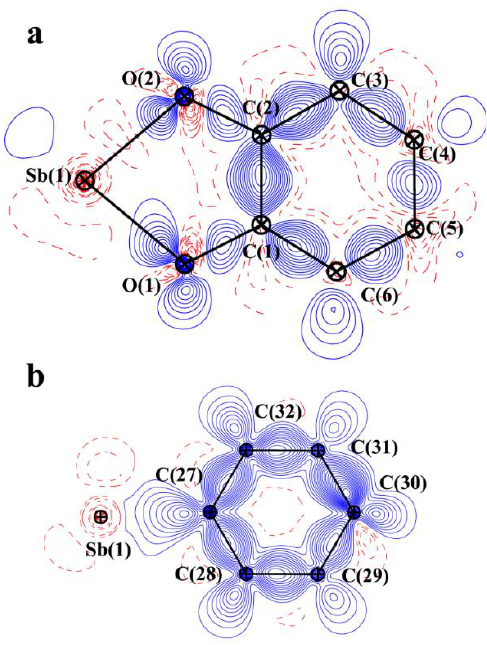
Figure 9. Experimental DED sections in 5 ED (contour ± 0.05 e/Å 3 ): the plane of the Sb(1)O(1)O(2) fragment ( a ); the plane of the Ph ligand ( b ). The solid lines (blue) show the concentration of DED, whereas the dashed lines (red) show the depletion of DED. H atoms are omitted for clarity.